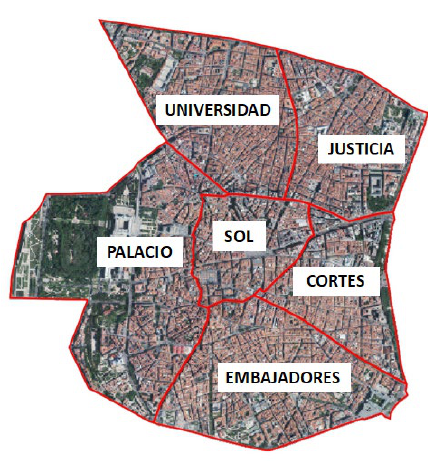
Figure 2. Division of the Distrito Centro into neighbourhoods and location of the University neigh-